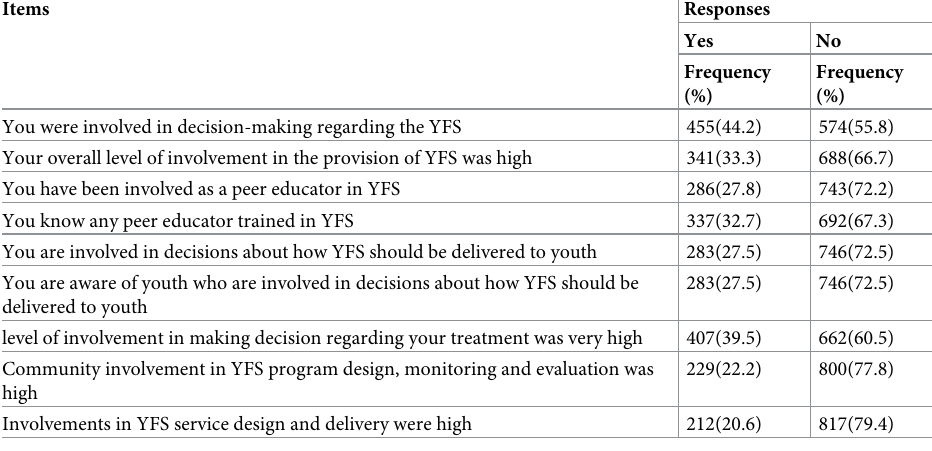
Table 3. Youths level of engagement in the YFS intervention, Northwest Ethiopia,